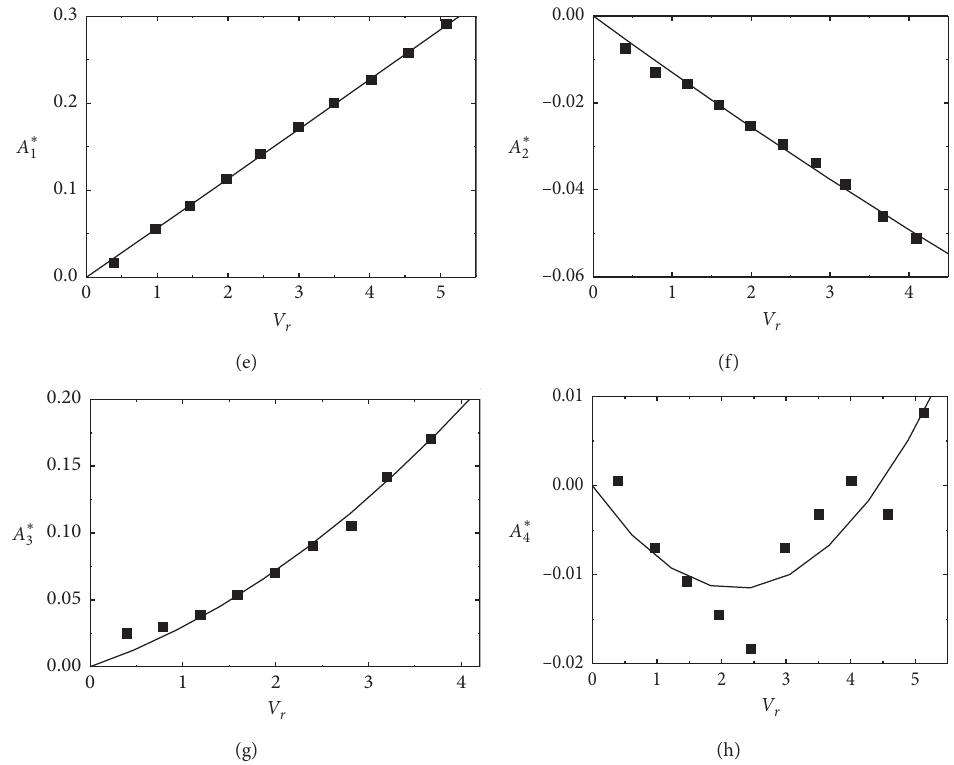
Figure 3: Fitting curves of flutter